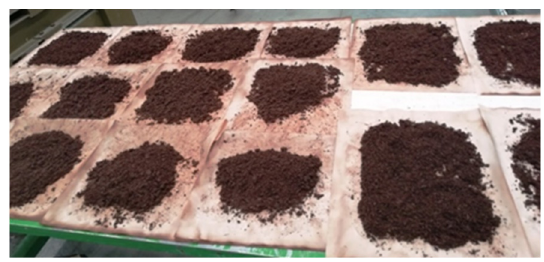
Figure 2. Wet olive